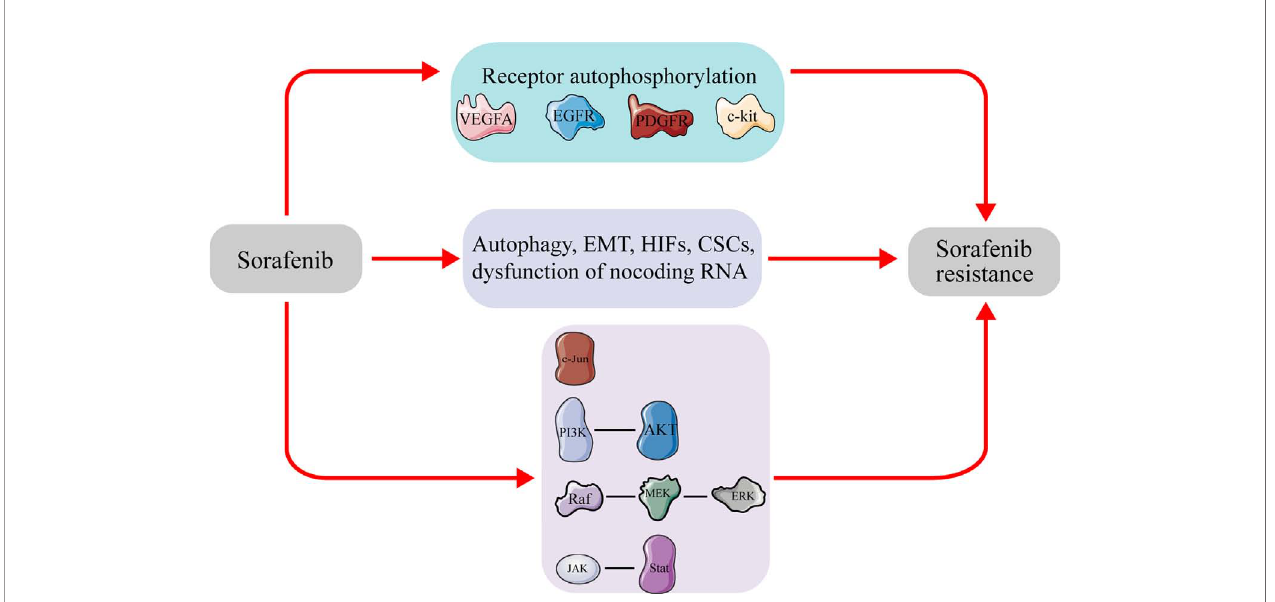
FIGURE 1 | Molecules and signal pathways related to sorafenib resistance in hepatocellular carcinoma. Sustained sorafenib treatment will affect the expression of the molecules and activate pathways, leading to sorafenib resistance in hepatocellular carcinoma. VEGFA, vascular endothelial growth factor A; EGFR, epidermal growth factor receptor; PDGFR, Platelet-derived growth factor receptor; c-kit, tyrosine kinase receptors hepatocyte factor receptor; EMT, epithelial – mesenchymal transition; CSCs, cancer stem cells; PI3K, phosphatidylinositol-3-kinase; AKT, protein kinase B; ERK, extracellular signal-regulated kinase; JAK, janus tyrosine kinase; STAT, signal transducer and activator of